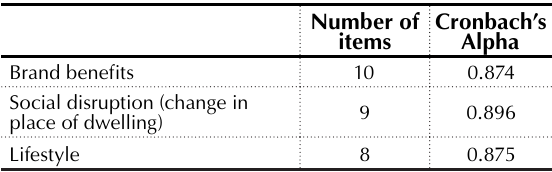
Table 1. Reliability of the research instrument